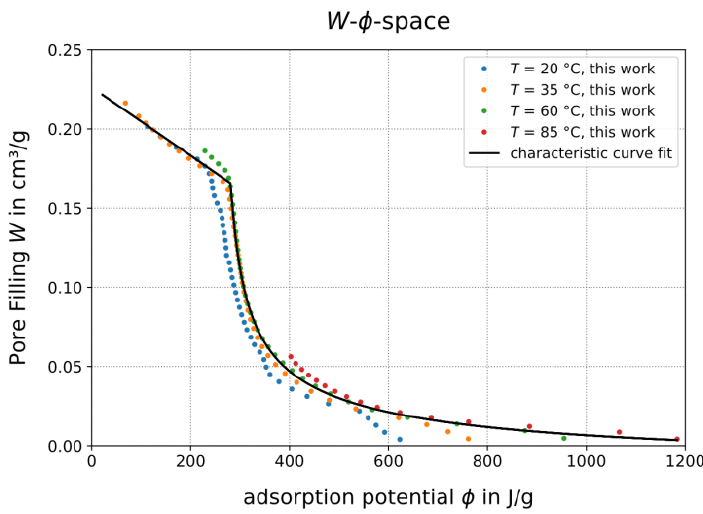
Figure 10. Description of the characteristic curve of granular TAPSO-34 by a straight line in the range of low adsorption potential and a third-order fractional polynomial in the range of high adsorption potential.